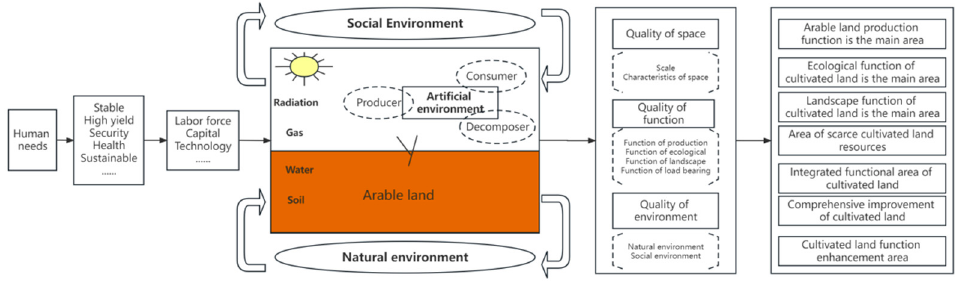
Figure 2. Structural diagram of cultivated land space–function–environmental quality evaluation system.